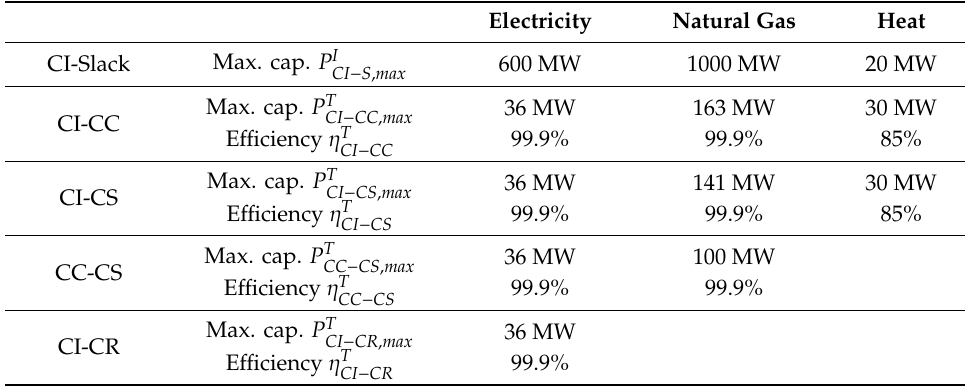
Table 2. Installed slack node capacities and installed grid capacities and efficiencies.